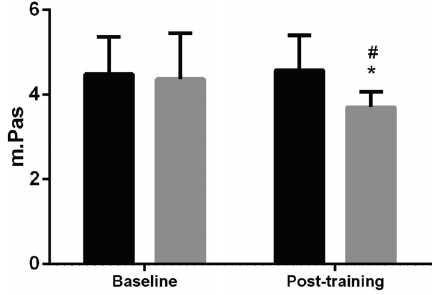
Figure 2. Blood viscosity. Control group: black bars; Experimental group: gray bars. Data are reported as means ± SD. *P p 0.05 compared to baseline; # P p 0.05 compared to control group (two-way repeated measures ANOVA with a Duncan post hoc test).